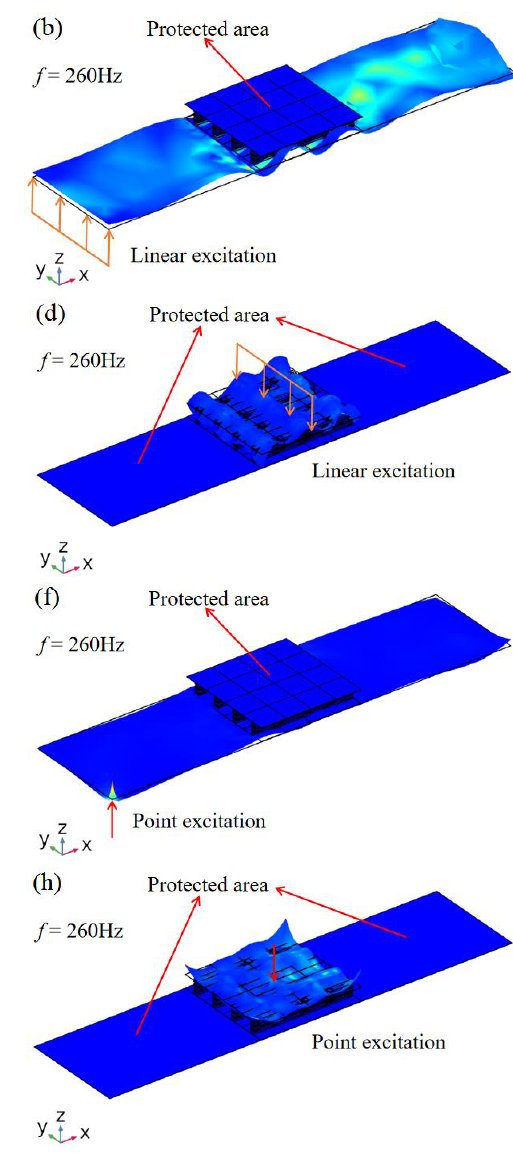
Figure 15. Displacement field of vibration isolation platform under different excitation. ( a ) When f = 60 Hz, under linear excitation at the left. ( b ) When f = 260 Hz, under linear excitation at the left. ( c ) When f = 60 Hz, under linear excitation in the middle section. ( d ) When f = 260 Hz, under linear excitation in the middle section. ( e ) When f = 60 Hz, under point excitation at the left. ( f ) When f = 260Hz, under point excitation at the left. ( g ) When f = 60 Hz, under point excitation in the middle section. ( h ) When f = 260 Hz, under point excitation in the middle section.